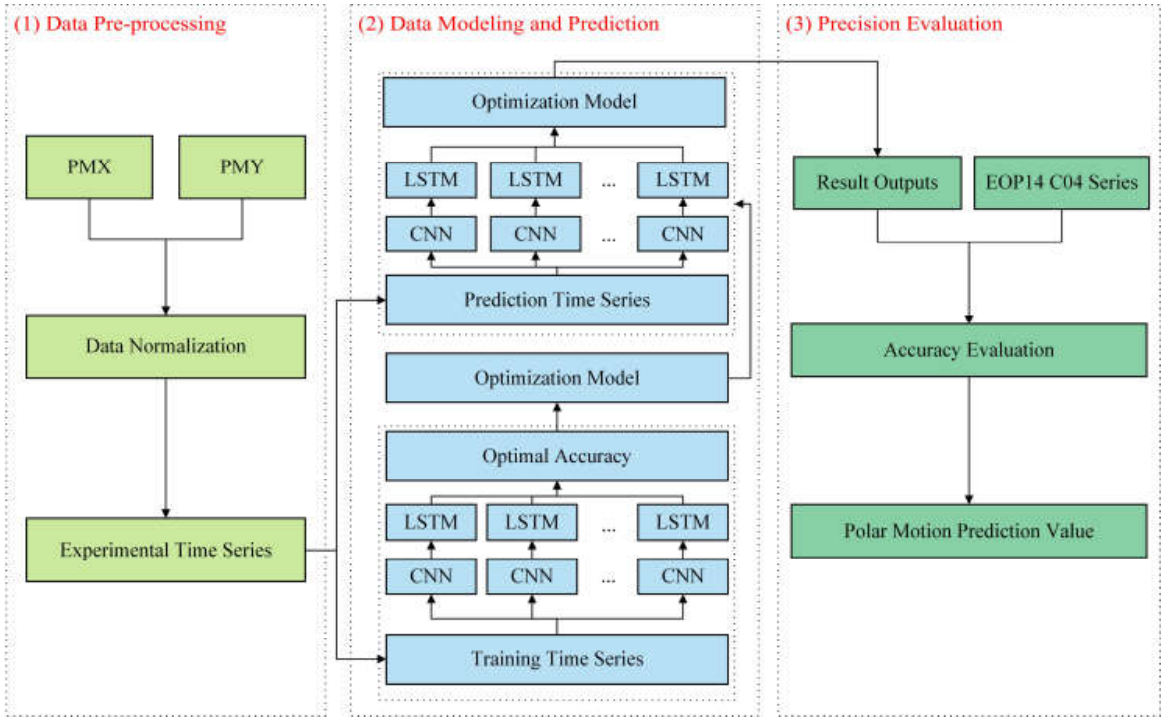
Figure 4. Flowchart of polar motion prediction using hybrid CNN–LSTM model.